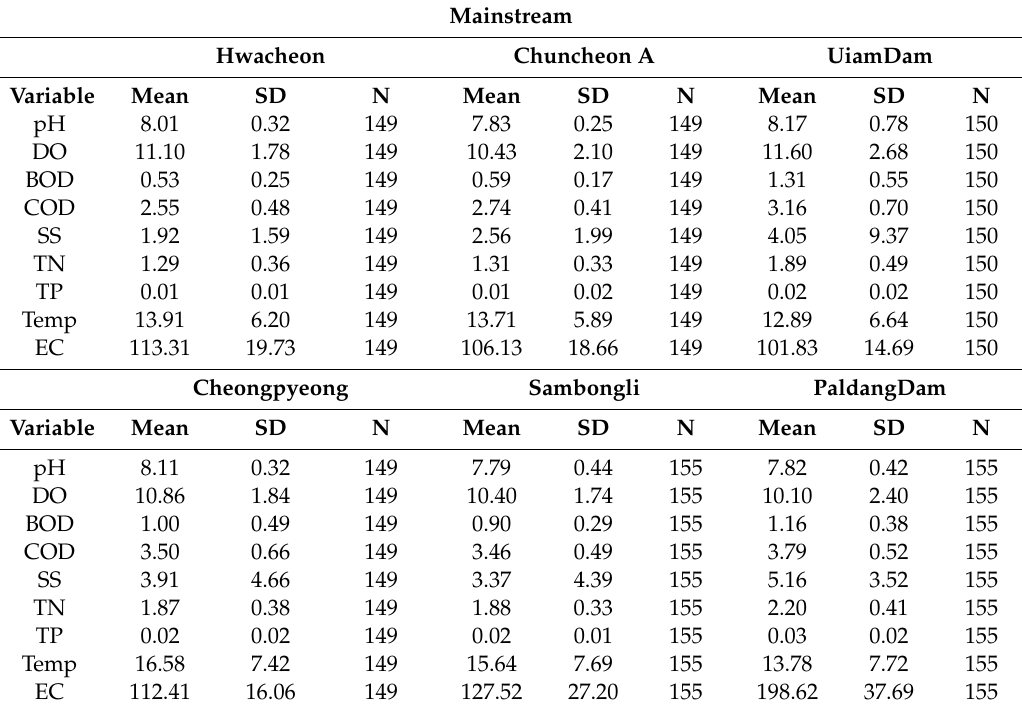
Table 3. Characteristics of variables recorded by monitoring stations of the Bukhan